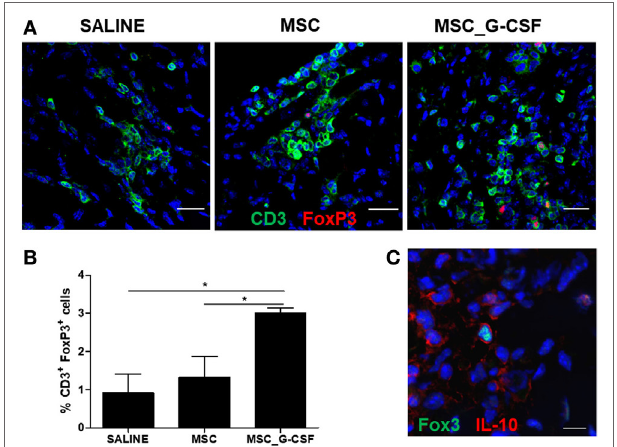
FigUre 3 | Mobilization of regulatory T cells (Tregs) in the hearts of mice transplanted with MSC_G-CSF. (a) Heart sections from Trypanosoma cruzi -infected mice treated with mesenchymal stem cells, MSC_G-CSF, or saline were stained for CD3 (green) and FoxP3 (red). (B) Quantification of Tregs represented the percentage of CD3 + FoxP3 + within CD3 + T cells. Values represent the mean ± SEM of five mice/group. * P < 0.05. (c) Heart section from T. cruzi -infected mice treated with MSC_G-CSF co-stained for FoxP3 (green) and IL-10 (red). Bars = 50 µm (a) and 10 µm (c) .